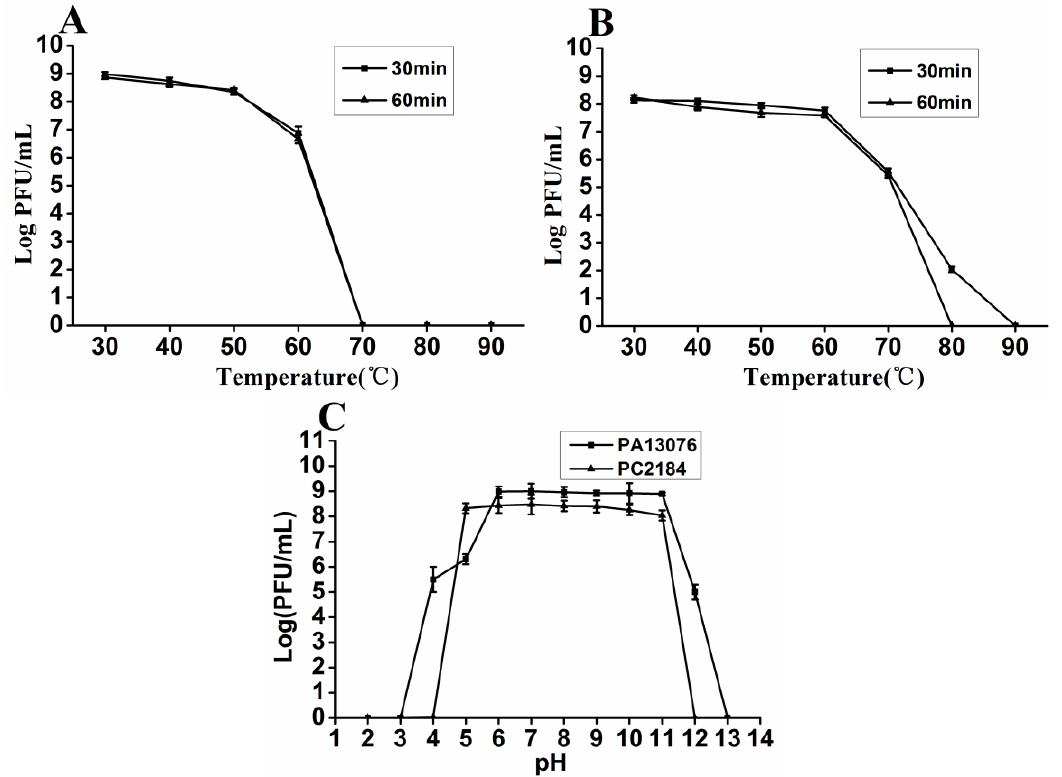
Figure 2. The thermal stability of phages PA13076 ( A ) and PC2184 ( B ); and the pH stability of phages PA13076 and PC2184 ( C ).